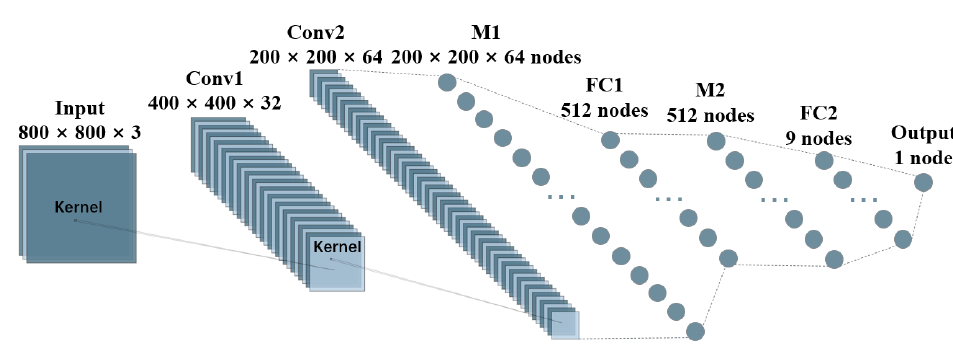
Figure 3. Data dimension of the proposed BN-CNN